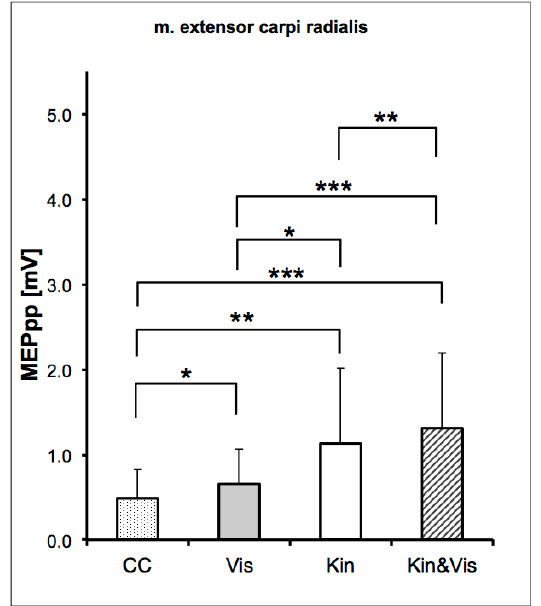
Figure 5. Mean MEP ( ± SD) across subjects, as a function of the four experimental conditions. Post-hoc comparisons of the MEP between all conditions shows significant differences. The MEP amplitudes shows an accumulation over the three different movement related modalities. The MEP amplitudes were presented as the mean ± standard deviation (SD). Significant differences in the MEP are presented with * p < 0.05, ** p < 0.01, and *** p < 0.001. The LSD (least significant difference) post-hoc test for the pairwise comparison of differences between the factors showed for a significant difference all conditions. The results of the paired comparison for each condition are presented in Table 1. The greatest difference was detected between the CC and the VIS & KIN condition. A dominant in- fluence of kinaesthetic and visual motor information on motor preparation is evident. In all subjects, we found a modulatory effect of the sensory integration on the corticospinal excitability. Table 1. This table shows the post hoc results of the LSD pairwise comparisons between the three stimulation conditions and the control condition. We found significant differences for all compar- isons. The LSD Test is based on the two-sample t -test. * p < 0.05, ** p < 0.01, and *** p < 0.001. Condition